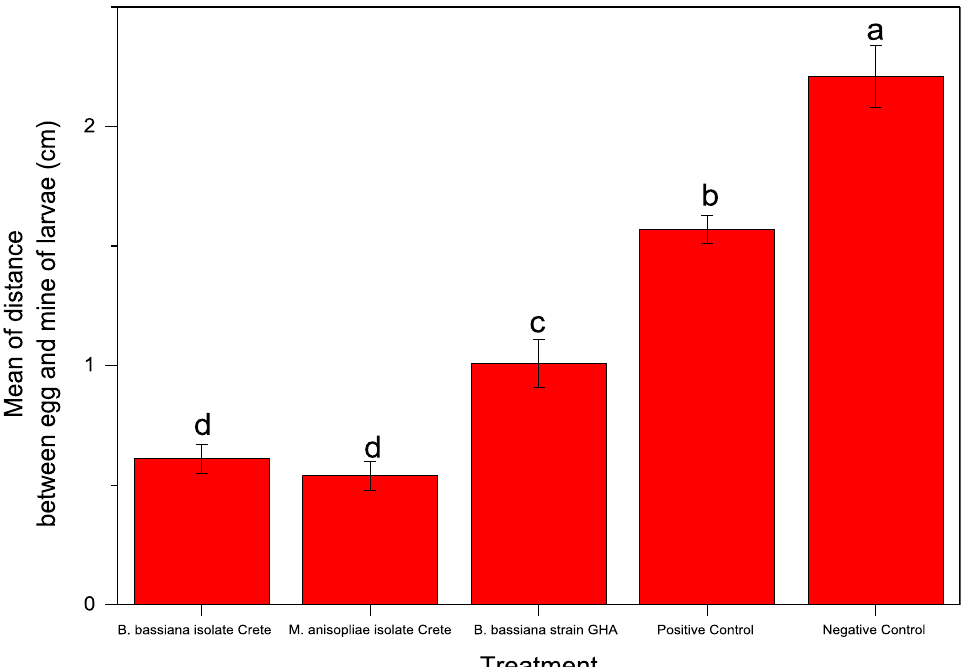
Fig. 2 Means ( se) of period between the egg and the mine of the larvae developed in fungi‑free (control) plants and plants colonized by ± Beauveria bassiana isolate Crete and Metarhizium anisopliae isolate Crete and B. bassiana strain GHA after 15 DPI* (days per irrigation) or irrigated by a chemical insecticide (Positive control). Means of the same column followed by the same letter are not significantly different (HSD, p < 0.05)